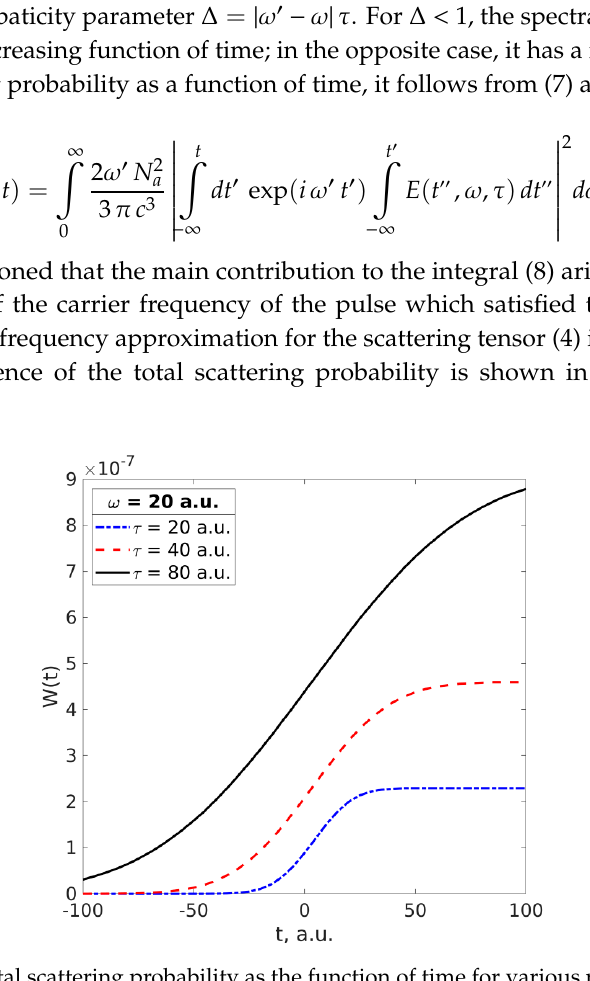
Figure 3. The total scattering probability as the function of time for various pulse durations.